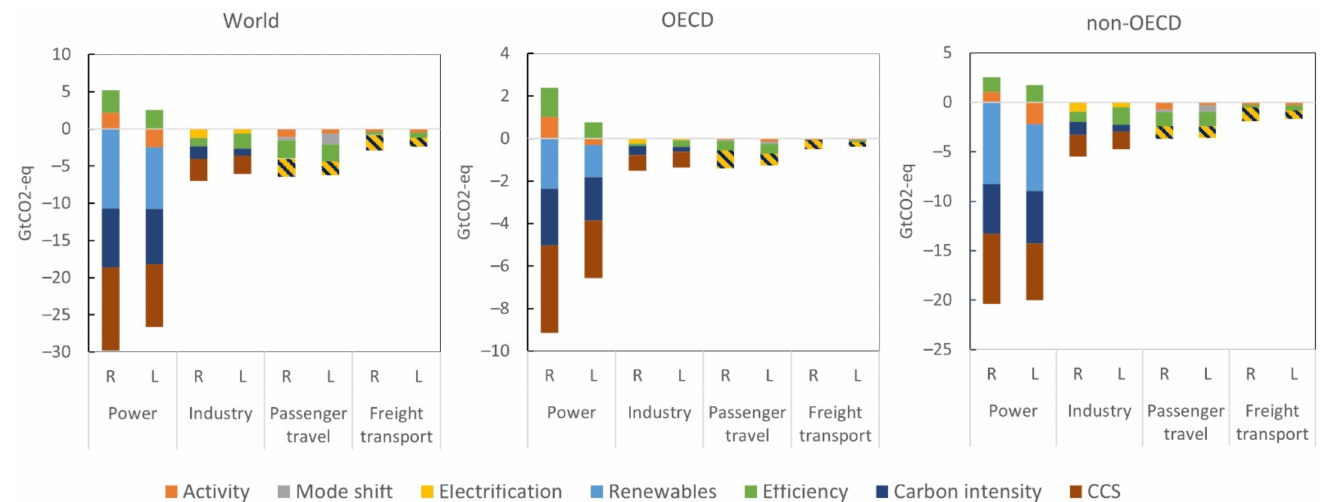
Figure 10. Changes in global emissions in mitigation scenarios by driving factor relative to the Baseline, 2050. R: Renewable, L: Lifestyle. Emissions from international bunkers are only shown in the global graph. Electrification and carbon intensity are one decomposition term in transport and therefore shown